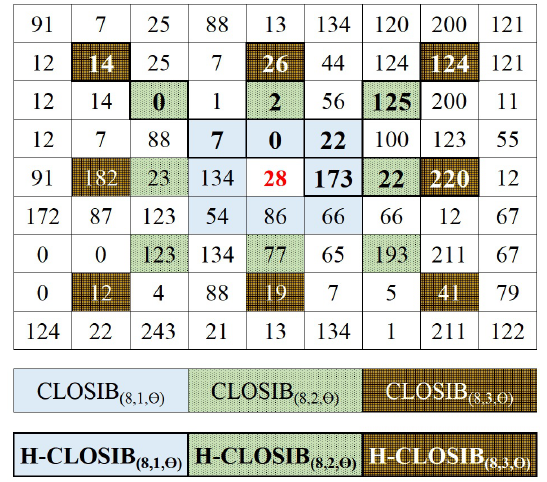
Figure 3. (Better viewed in color) Neighborhood around a center pixel, (28), considered for the computation of M-CLOSIB 8,1, θ and HM-CLOSIB 8,1, θ . CLOSIB considers P = 8 (cid:102) 8,2, θ (cid:102) 8,3, θ (cid:102) 8,2, θ (cid:102) 8,3, θ orientations, while H-CLOSIB only P = 4 orientations. In the figure, neighbour pixels considered for H-CLOSIB are shown in